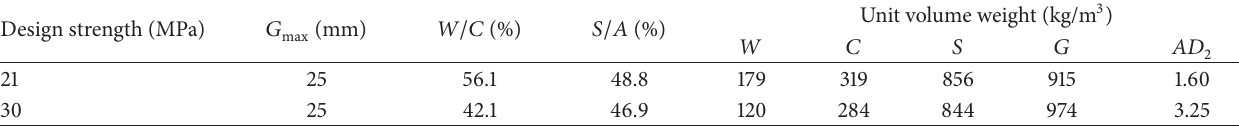
Table 3: Concrete mix proportion.